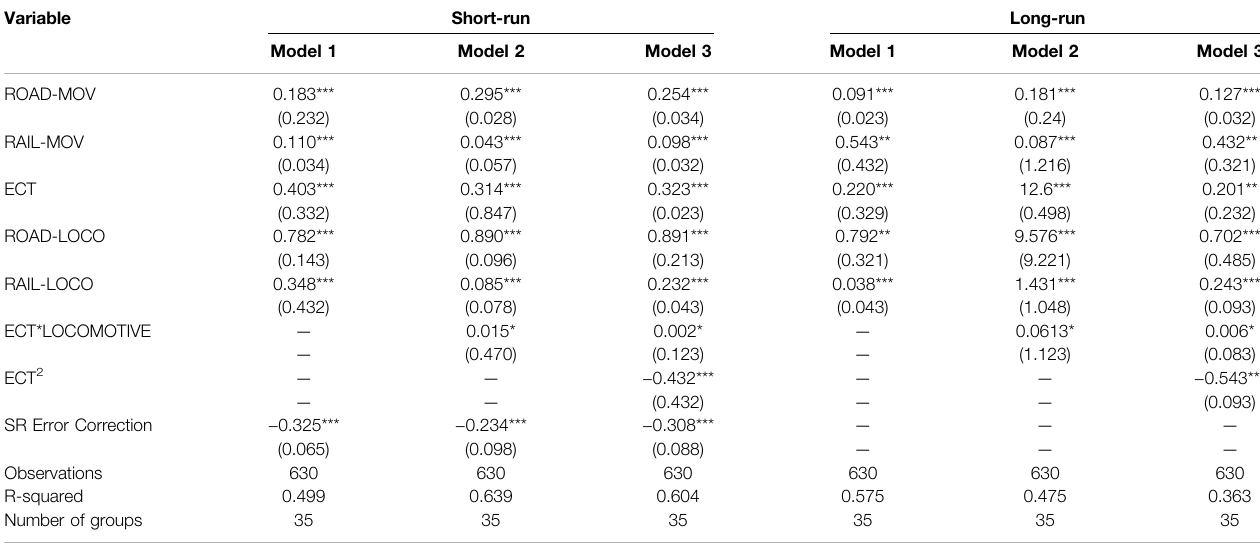
TABLE 6 | The role of traf fi c and transport energy